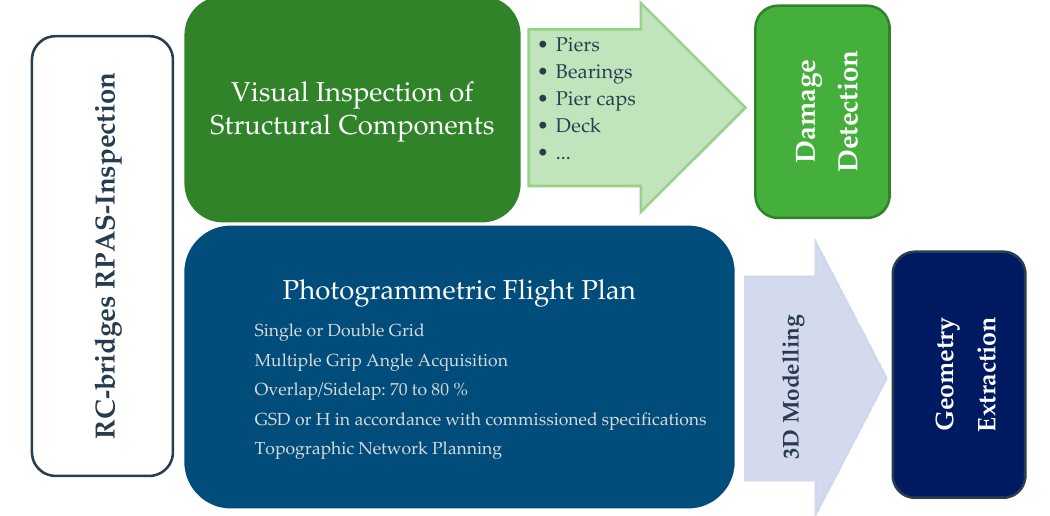
Figure 1. Remotely Piloted Aircraft Systems (RPASs)-based inspection in a simplified schematization. A RPAS investigation of Reinforced Concrete (RC)-bridges was basically divided into visual inspection and photogrammetric operations to provide a measure of the deterioration and geometry of the structure, respectively.